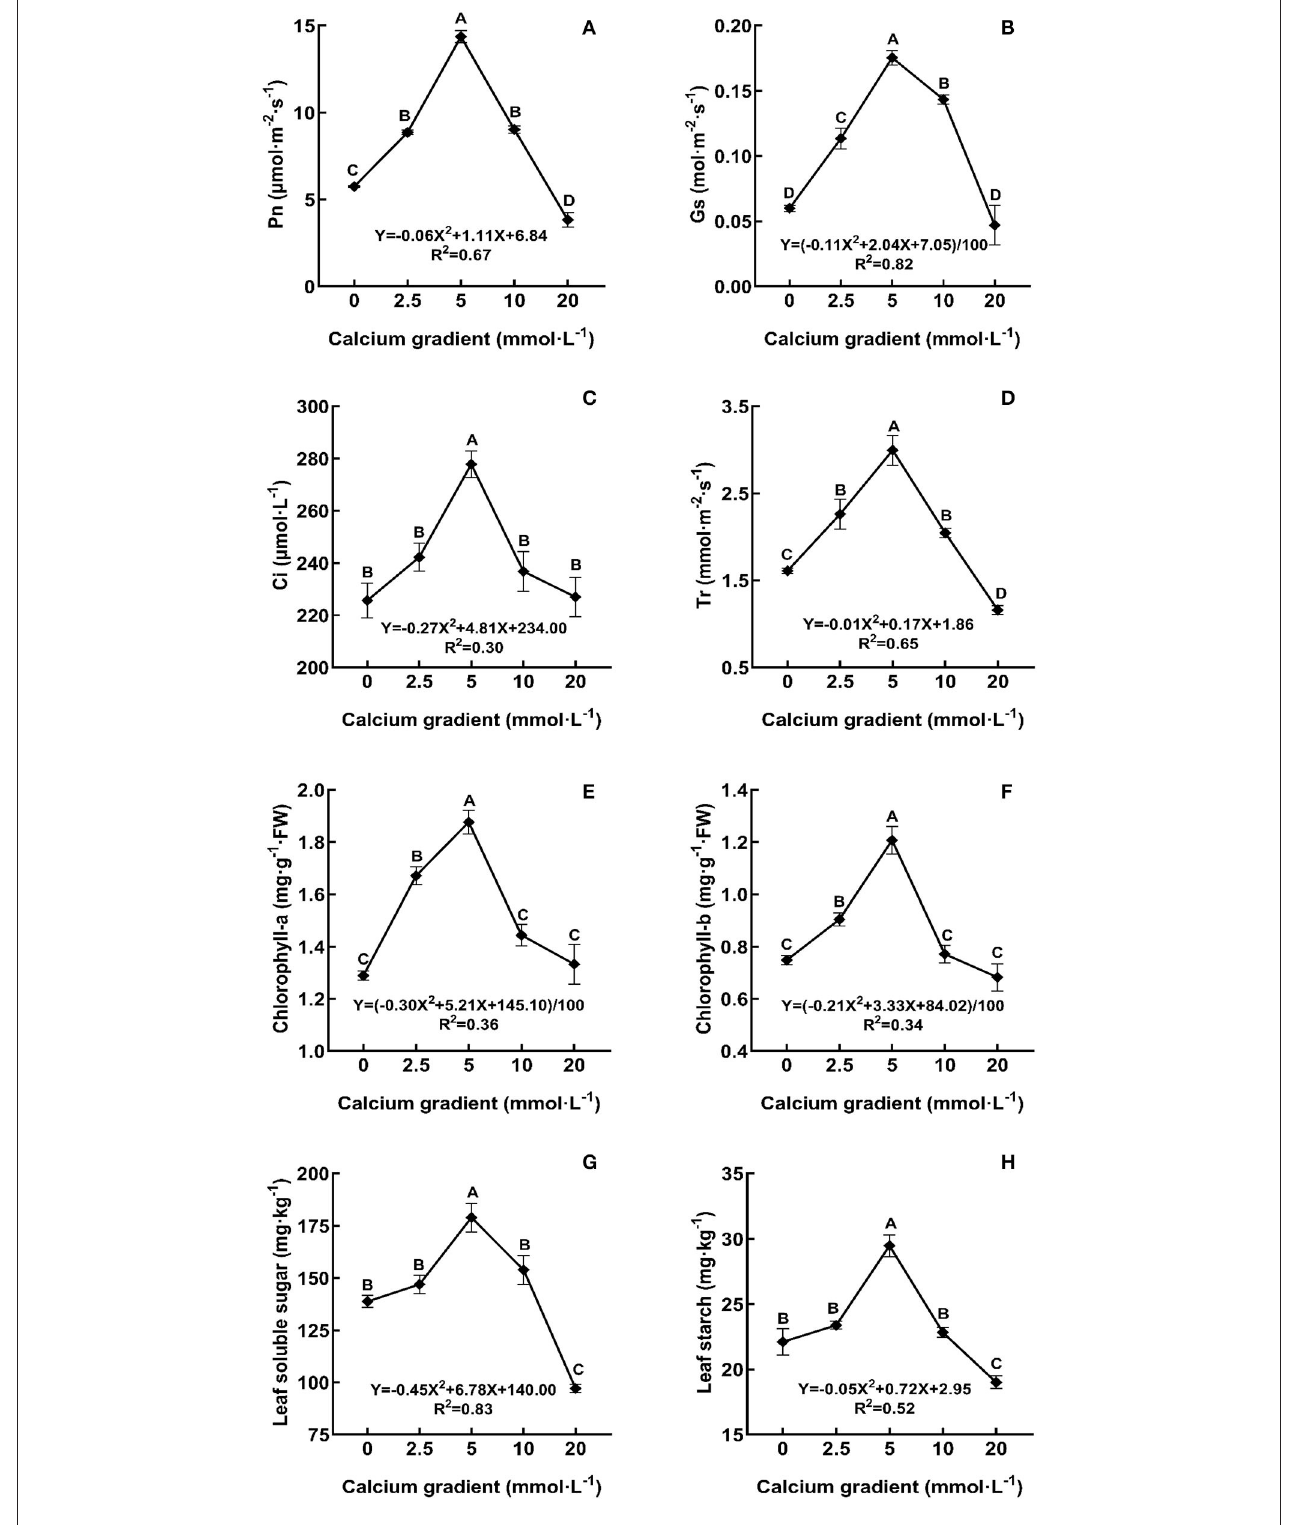
FIGURE 3 | Photosynthetic characteristics of poplar seedlings in different treatments. Each column shows the mean ± SE value, n = 3. Different capital letters indicate significant differences between treatments of calcium addition ( P < 0.05).